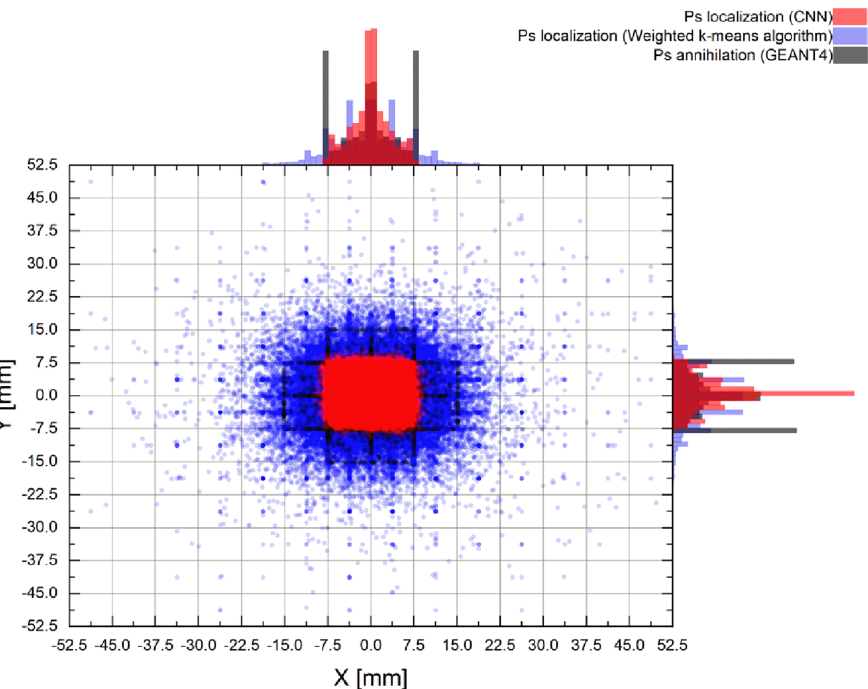
Figure 3. The obtained Ps annihilation localizations for the case of 18 F using the CNN and the weighted k-means algorithm; the XY coordinates are for the top view of the KAPAE detector.